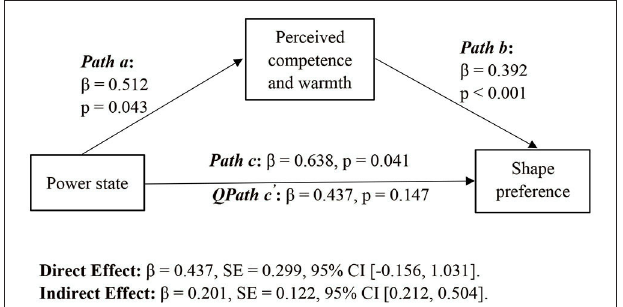
FIGURE 2 | Mediation analyses. * p < 0.05, ** p < 0.01, *** p <